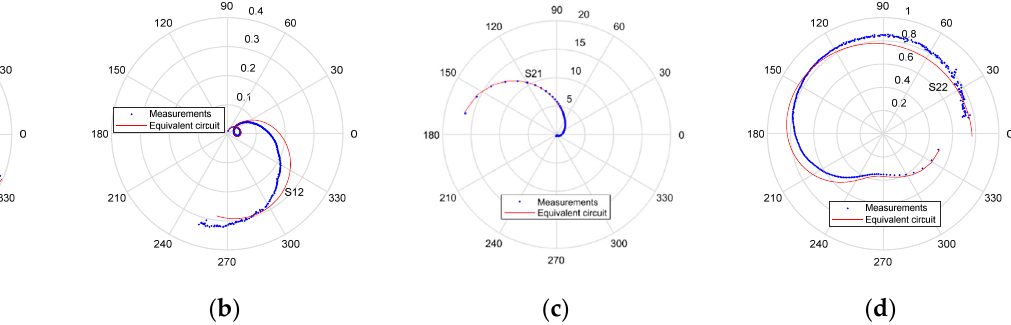
Figure 8. Measured (blue symbols) and equivalent-circuit simulated (red lines) behavior of ( a ) S 11 , ( b ) S 12 , ( c ) S 21 , and ( d ) S 22 with the frequency range spanning from 200 MHz to 65 GHz for the DUT at V DS = 30 V, V GS = − 3.1 V, and T a = 145 °C.